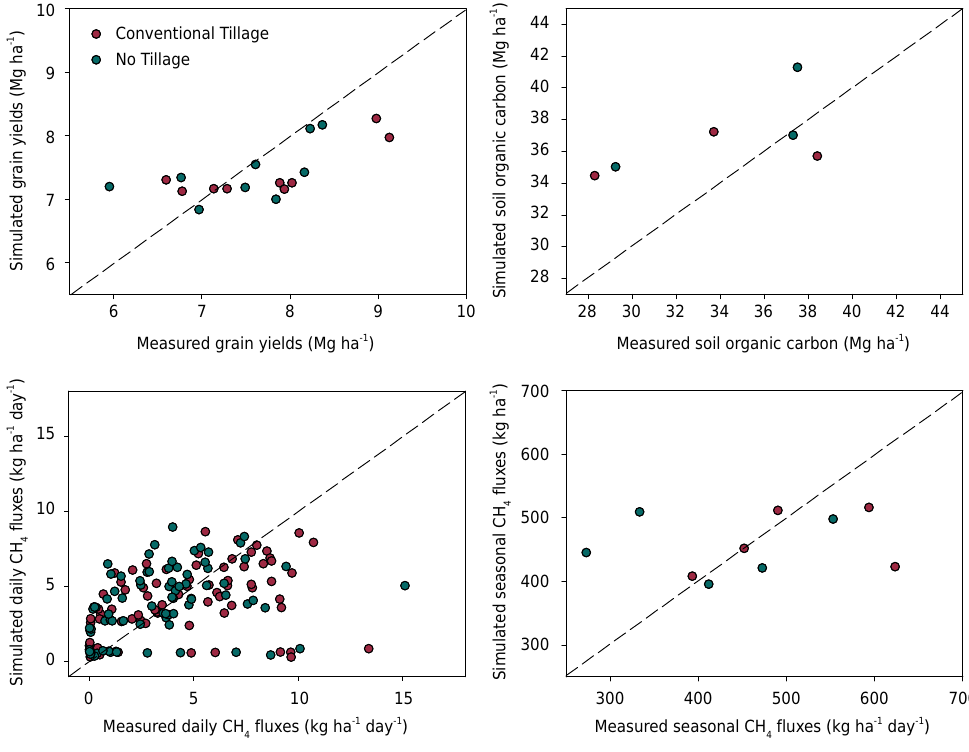
Figure 2. Comparison of observed and simulated rice grain yields, soil carbon, daily CH 4 fluxes, and seasonal CH 4 emissions under conventional and no-tillage.